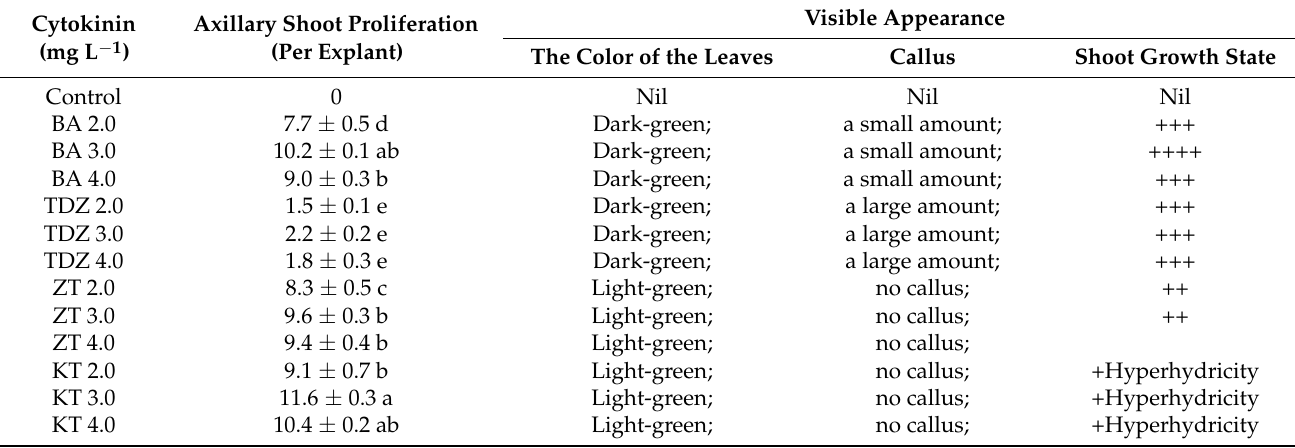
Table 1. Effect of cytokinins on axillary shoot proliferation from nodal segments of A. lupulina after culture for 35d. Cytokinin (mg L − 1